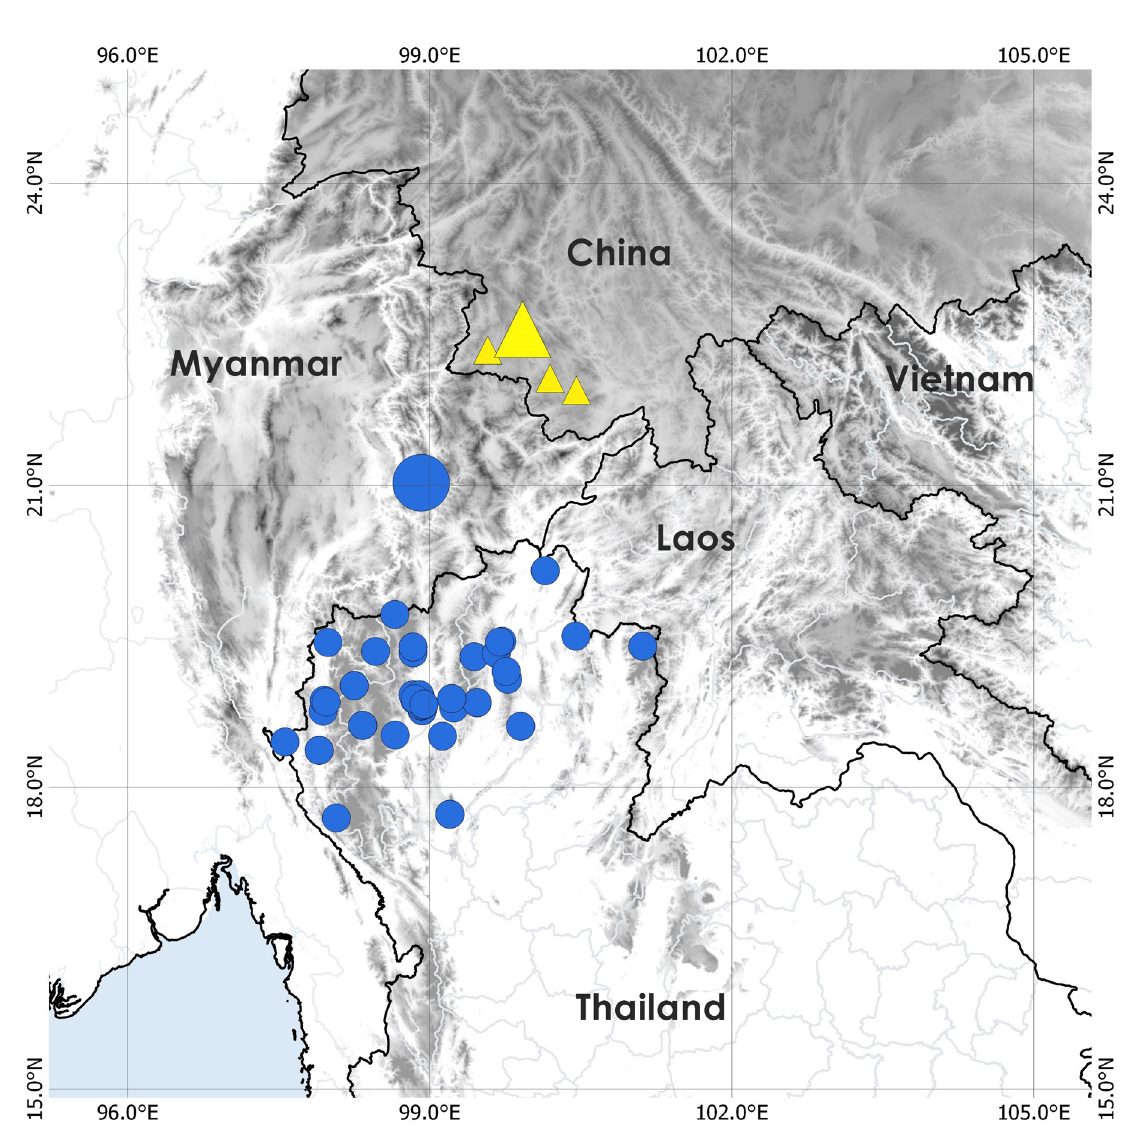
Fig. 10. Distribution range of G. insectifera Ridl. (circles) and G. lancangensis Q.Q.Yian (triangles). The type locality of each species is indicated by a bigger